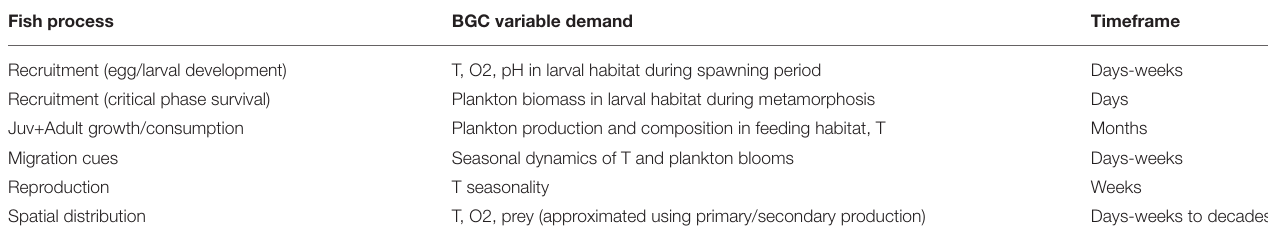
TABLE 1 | Biogeochemical model output variables of interest for purposes of constraining fish